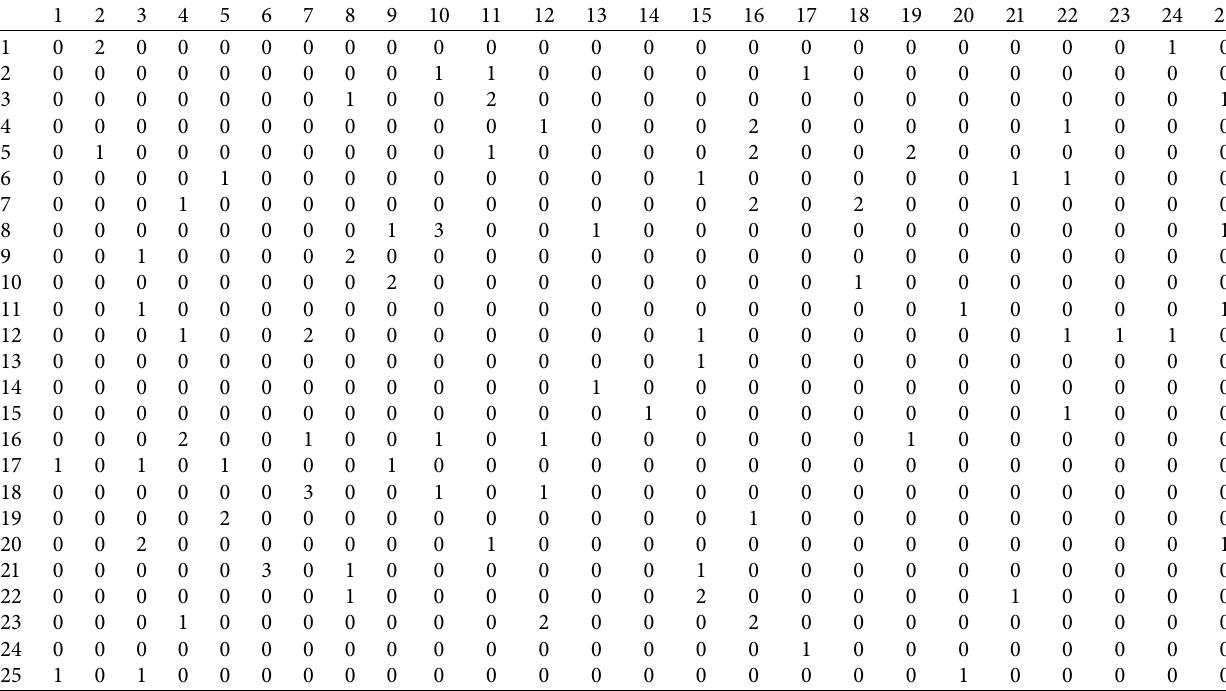
Table 3: Material flow matrix.